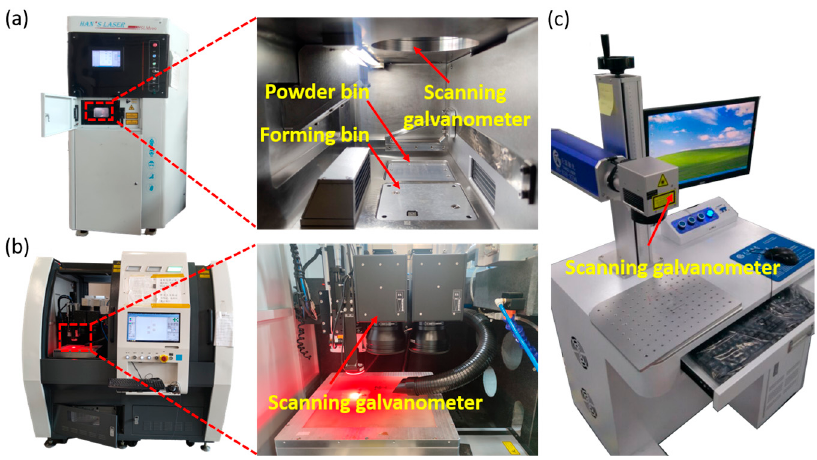
Figure 1. ( a ) SEM image and ( b ) size distribution of 316L stainless steel powders. Table 1. Chemical composition of the 316L stainless steel powder.